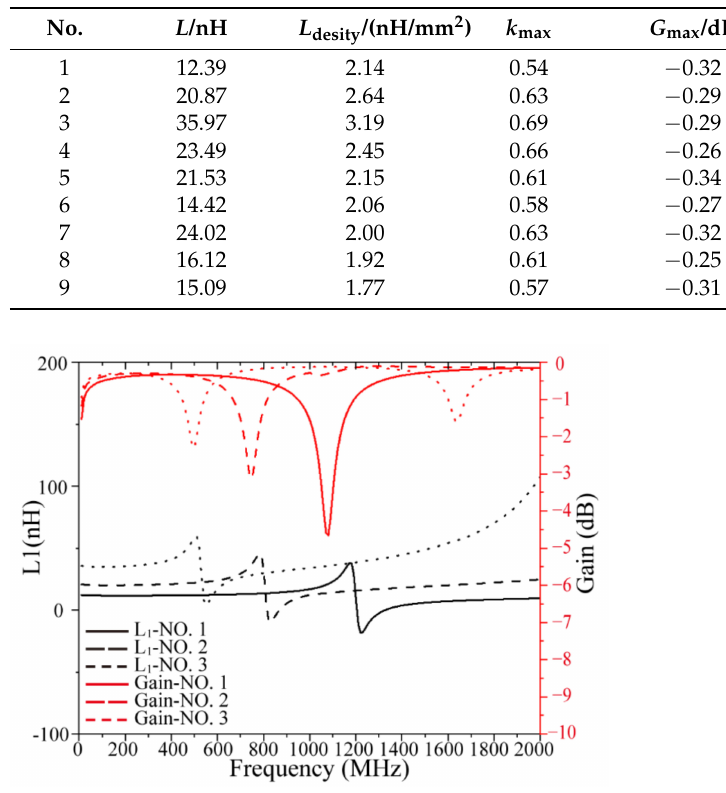
Table 2. Simulation result of solenoidal transformer with air core.